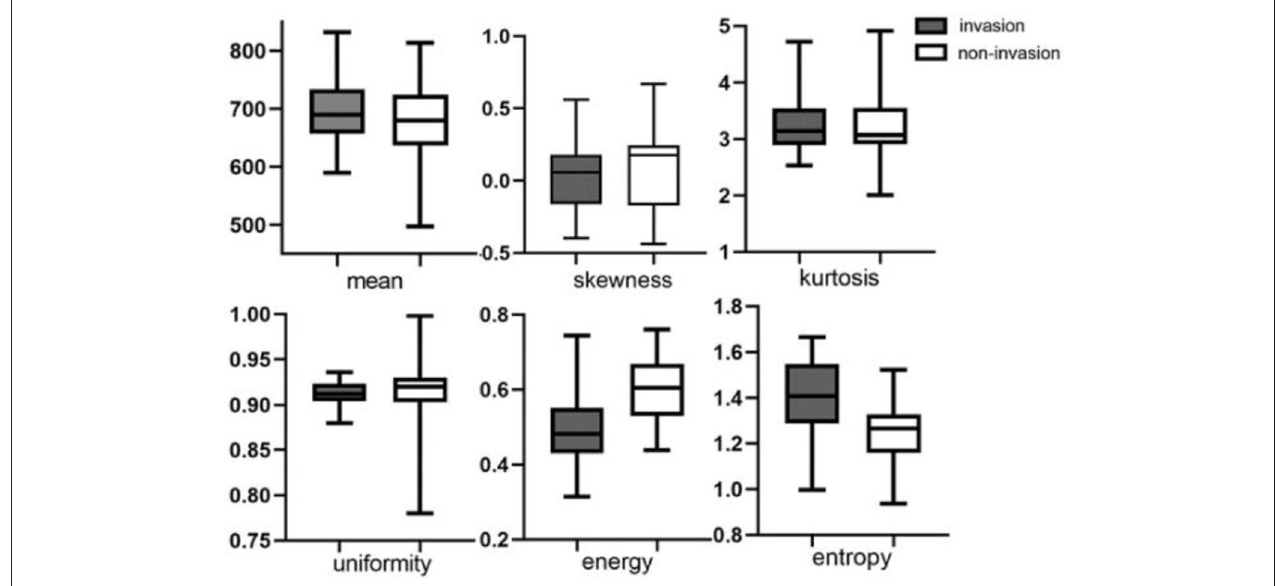
FIGURE 2 | Boxplots of texture features of mean value, skewness, kurtosis, uniformity, energy, and entropy between invasion and non-invasion groups.